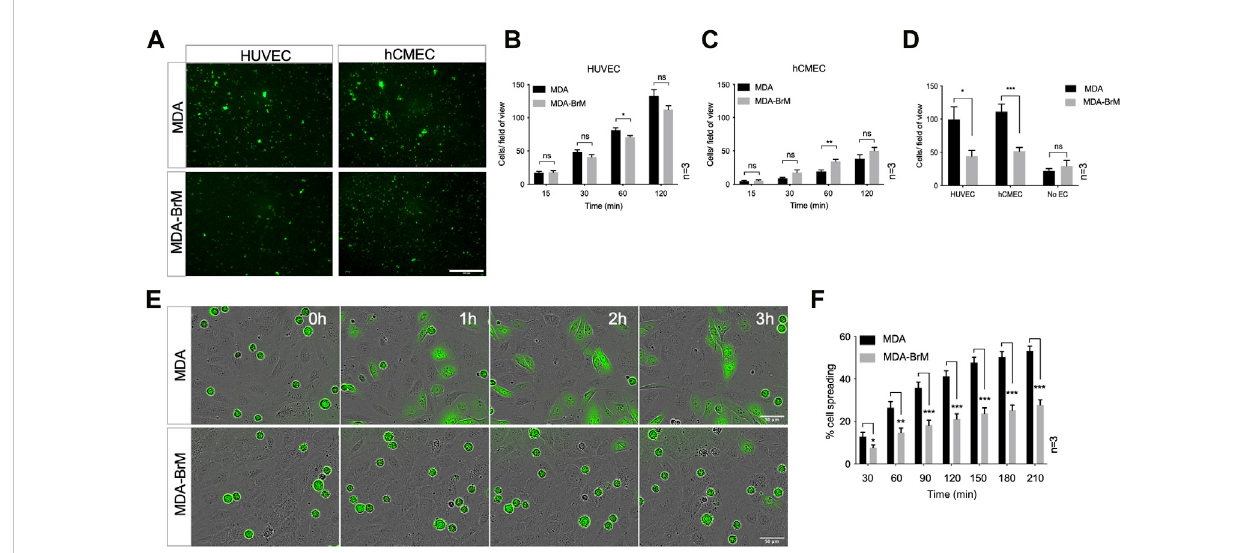
FIGURE 1 Adhesion of breast cancer cells to endothelial cells. (A) Adhesion of CTG labelled breast cancer cell lines MDA-MB-231 (MDA) and brain metastatic variant(MDA-BrM)toHUVECandhCMECendothelialmonolayers.Imagesshowadhesionatthe60 mintimepoint.Scalebar:500 μ m. (B) Quanti fi cation of adhesion of MDA and MDA-BrM to HUVEC monolayers for indicated time points. Data are derived from three independent experiments. Error bars indicatestandarderrorofthemean(S.E.M).AnalysiswasperformedusingmultipleunpairedTtesting;* p < 0.05;ns,notsigni fi cant. (C) Quanti fi cation of adhesion of MDA and MDA-BrM to hCMEC monolayers for indicated time points. Data are derived from three independent experiments. Error bars indicate S.E.M. Analysis was performedusing multiple unpaired Ttesting;** p < 0.01; ns, notsigni fi cant. (D) Quanti fi cation ofTEMofCTG labelled MDA or MDA-BrM seeded to HUVEC and hCMEC monolayers grown in the upper chamber of a Boyden transwell insert, or an empty transwell insert for No EC condition. CTG cellsthat had migrated totheundersideofthetranswell fi lterwereimaged and quanti fi ed18 hpost-seeding.Data arederived from three independent experiments. Error bars indicate S.E.M. Analysis was performed using unpaired T testing; * p < 0.05; *** p < 0.001, ns, not signi fi cant. (E) MDA andMDA-BrM intercalation determined bylivecellimaging.MDAandMDA-BrM wereCTG labelled andseededto HUVECmonolayersandintercalation/ spreadingwascapturedusinglivecellimaging.Imagesweretakenevery 5 minfor3.5 husinga20xobjective. Scalebar:50 μ m. (F) Quanti fi cationofdata in panel E, indicating the percentage of MDA or MDA-BrM cells that have undergone spreading/intercalation as a percentage of total cells. Data are derived from three independent experiments. Error bars indicate S.E.M. Analysis was performed using multiple unpaired T testing; * p < 0.05; ** p < 0.01; *** p <